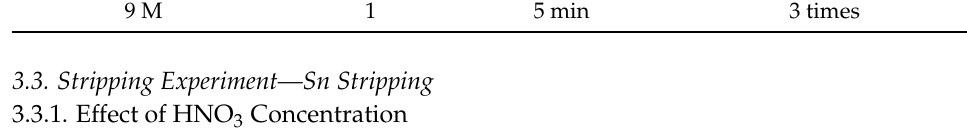
Figure 9. Stripping percentage of Sn and Sb at different numbers of stripping times. (HCl) = 9 M, O/A ratio = 1, reaction time = 5 min.